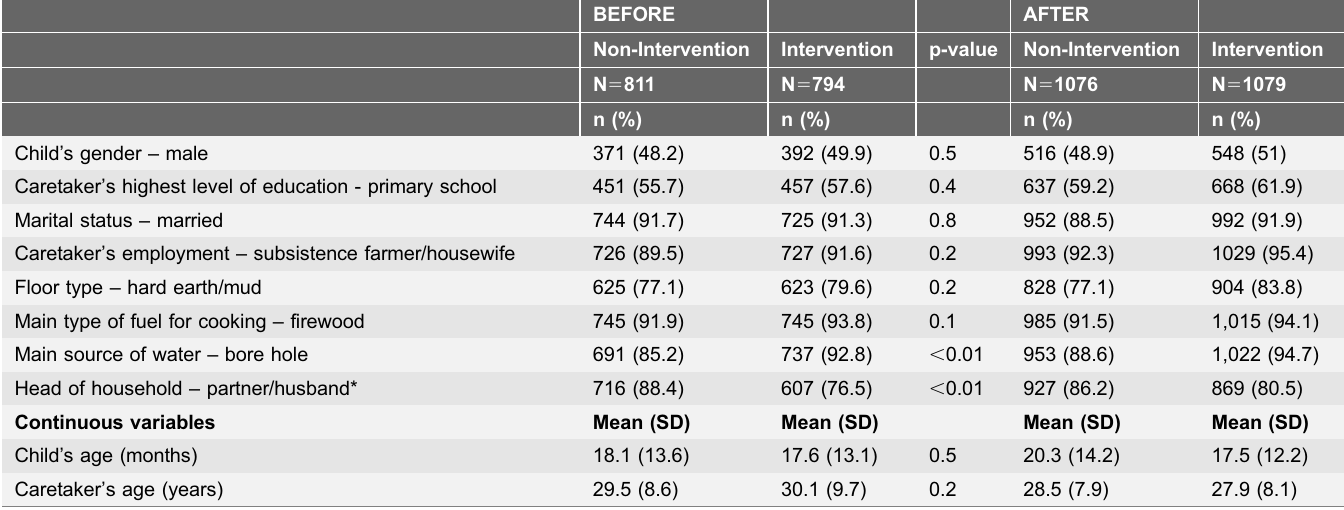
Table 1. Characteristics of participating children and caretakers from household survey.